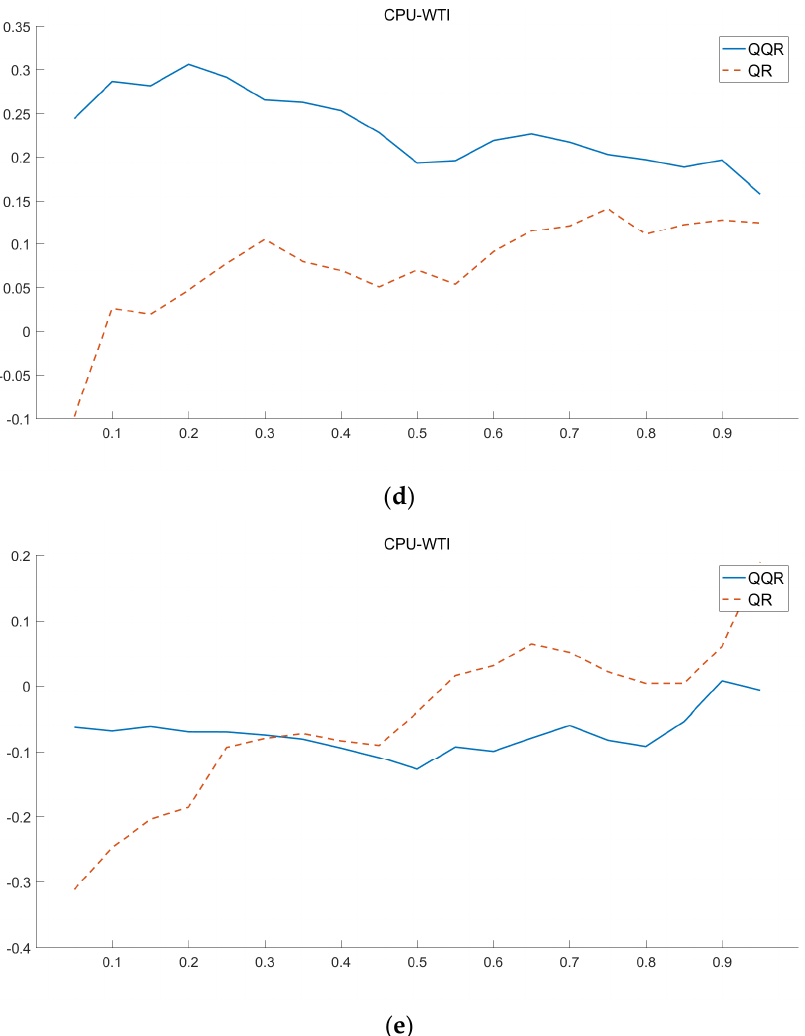
Figure 8. Comparison of impact coefficient estimates of the CPU on the WTI under QQR and Q.R. ( a ) Comparison of the impact of CPU on WTI under the Q.R. and the QQR at D1; ( b ) Comparison of the impact of CPU on WTI under the Q.R. and the QQR at D2; ( c ) Comparison of the impact of CPU on WTI under the Q.R. and the QQR at D3; ( d ) Comparison of the impact of CPU on WTI under the Q.R. and the QQR at D4; ( e ) Comparison of the impact of CPU on WTI under the Q.R. and the QQR at D5.